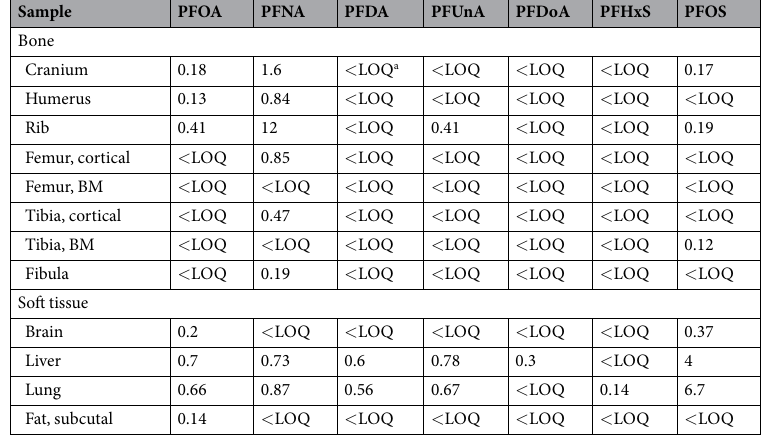
Table 1. Biopsy concentrations of PFAS (ng/g ww) from the cadaver. a Limit of Quantification.